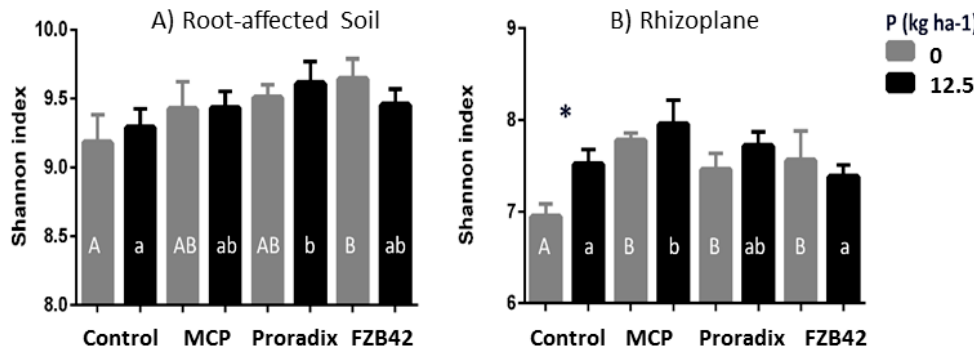
Figure 5. Shannon index for mean α -diversity of the bacterial communities in root-affected soil ( A ) and the rhizoplane ( B ) of drip-irrigated tomato plants with and without band placement of triple superphosphate (12.5 kg P ha − 1 ) and inoculation with different microbial biostimulants at 6 months after sowing, Negev Ramat, Israel. Significant differences (paired Student’s t -test) in Shannon index between 0 and 12.5 kg P ha − 1 dose of the same inoculant treatment are marked by *. Significant differences after pairwise comparison between inoculation treatments with the same P dose are indicated by different characters: A, B for 0 P, and a,b for 12.5 kg P ha − 1 .